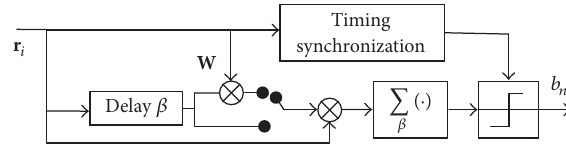
Figure 4: Block diagram of the proposed system